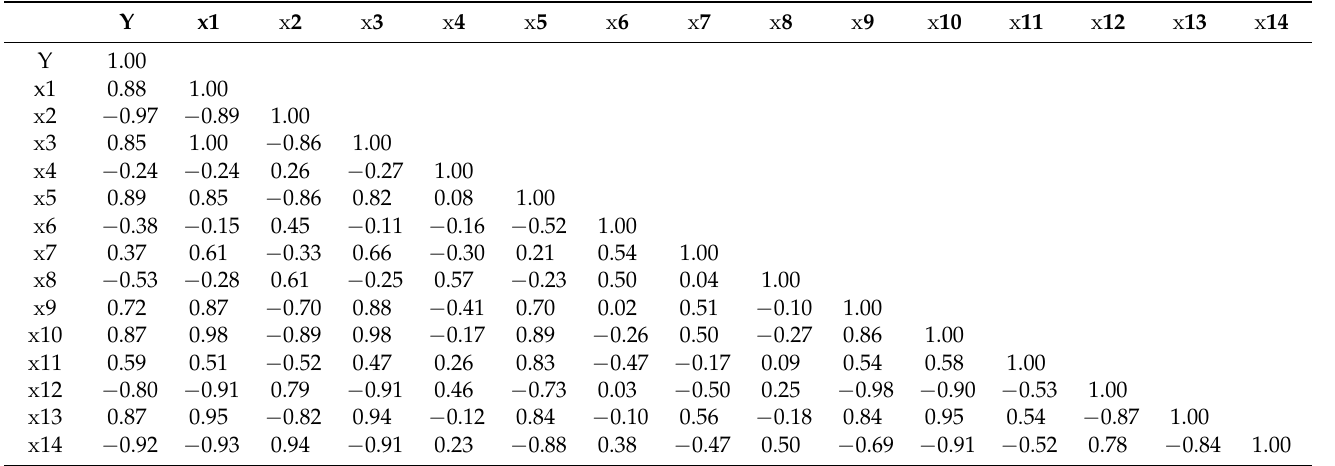
Table 2. Correlation matrix constructed based on the results of correlation